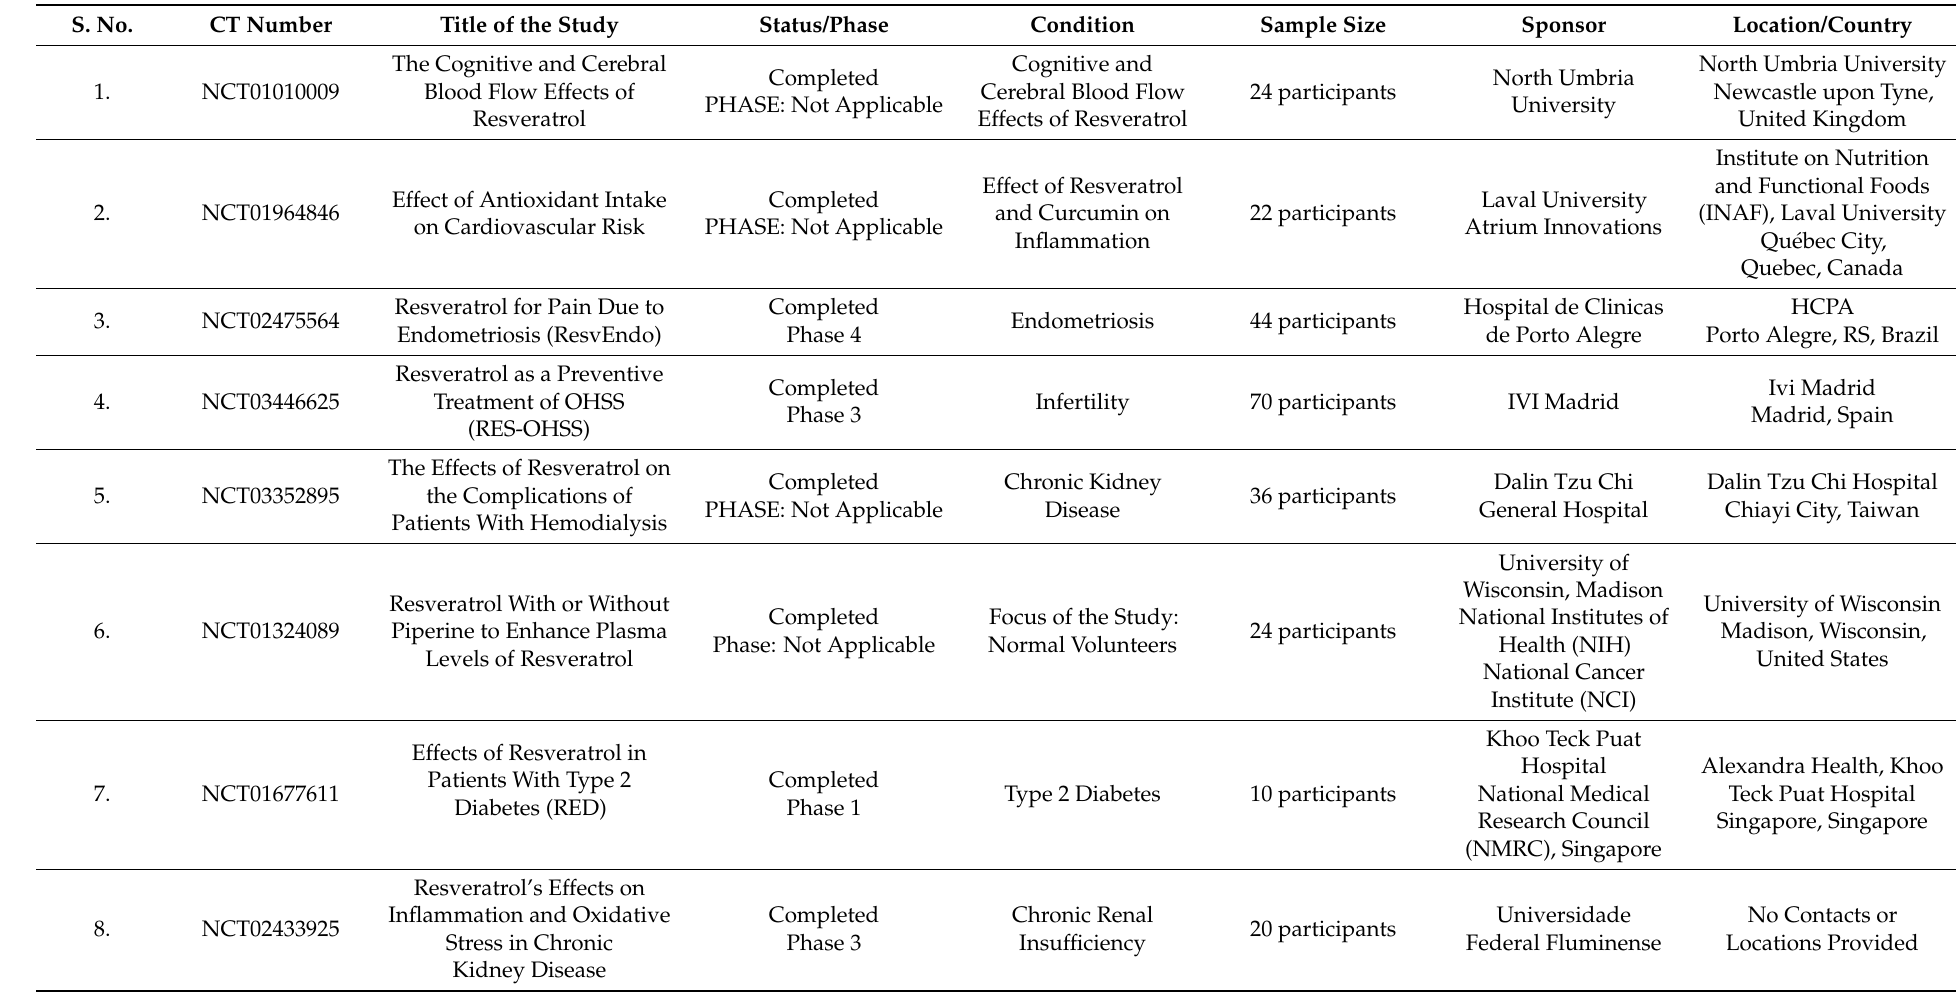
Table 5. List of global clinical trials on